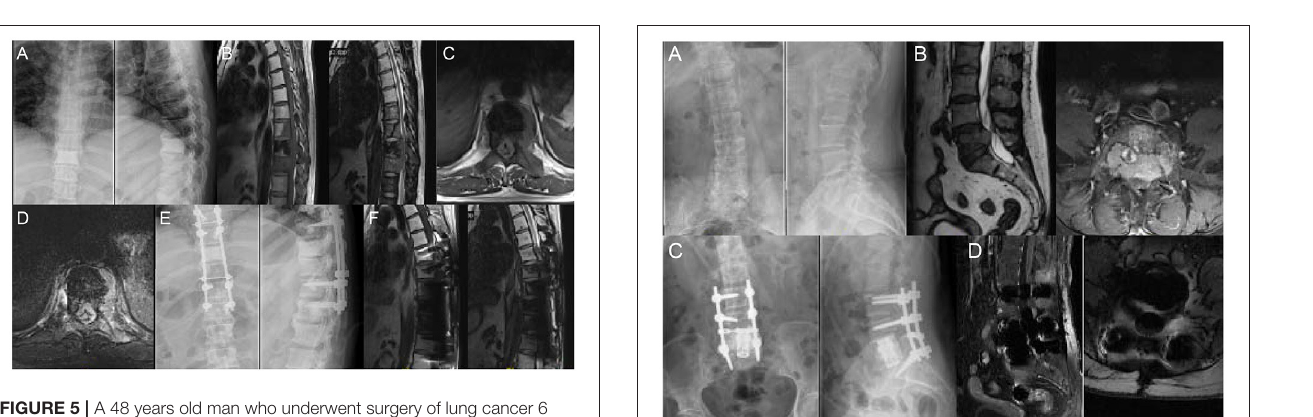
FIGURE 5 | A 48 years old man who underwent surgery of lung cancer 6 years ago complained of increasing osphyalgia during the previous 1 month and was found to have metastatic lesion in T8-10; His preoperative Frankel grade was D. (A) Preoperative anteroposterior and lateral radiograph revealed abnormal bone mineral density in T9. (B–D) Sagittal and axial magnetic resonance imaging (MRI) showing signal intensity abnormalities in T8-10 and a pathological fracture of T9. (E) Postoperative anteroposterior and lateral radiograph. (F) Postoperative sagittal MRI.